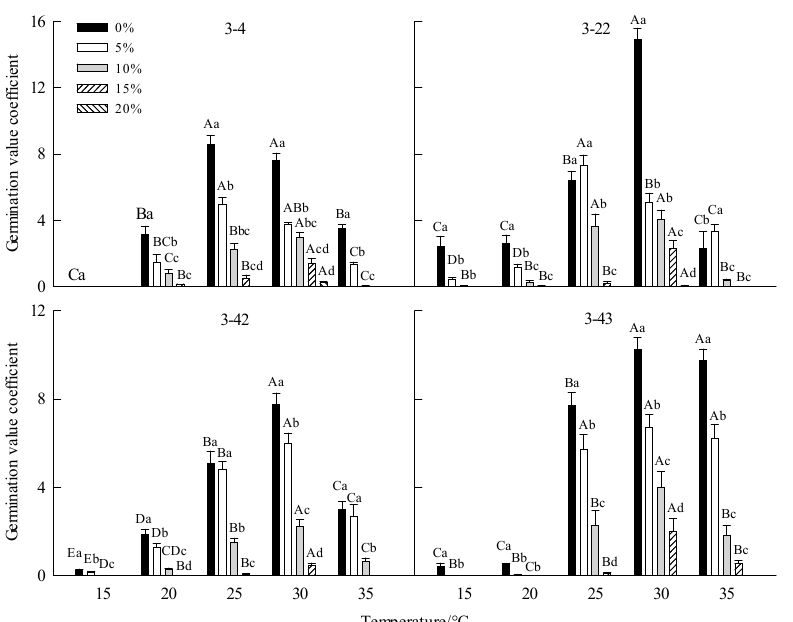
Figure 3. Effect of drought stress on seed germination value of Betula platyphylla in different families under different temperatures. Different capital letters stand for significant differences between different temperatures of the same PEG concentration ( p < 0.05), and different lowercase letters stand for significant differences between different PEG concentrations at the same temperature ( p < 0.05).